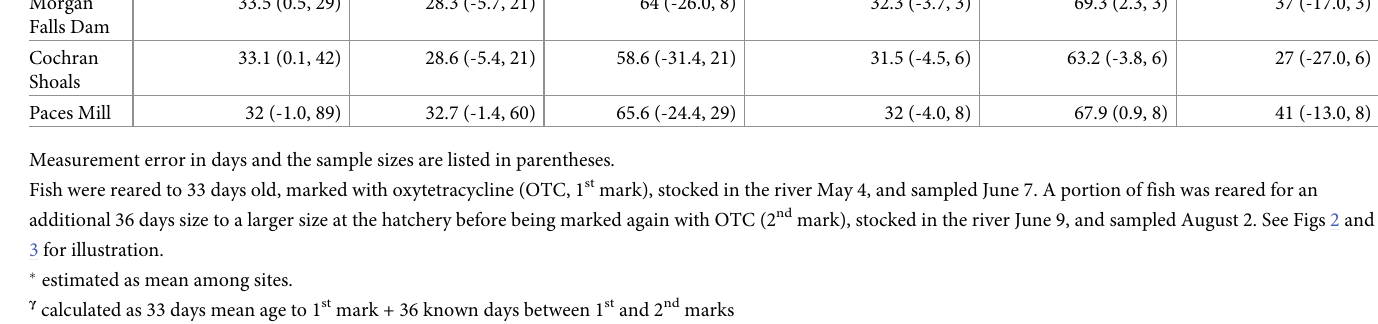
Table 2. Mean age estimates of Shoal Bass reared in hatchery ponds and stocked at three sites in the Chattahoochee River, Georgia in 2004. Site